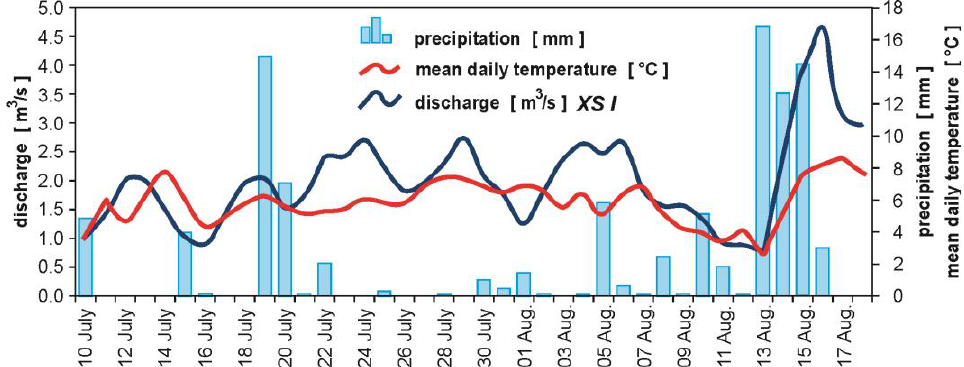
Figure 4. The course of changes in air temperature, precipitation and discharge during 2013 melting season.